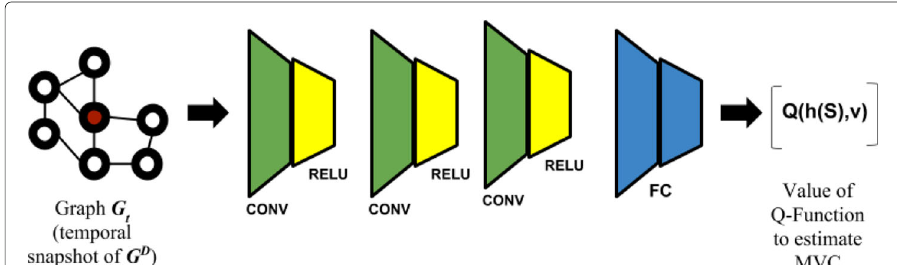
Fig. 4 Architecture illustration of the neural network used in our work. Green colored shape represents the convolutional layer. Yellow colored shape represents ReLU activation function. Blue colored shape represents the fully connected layer